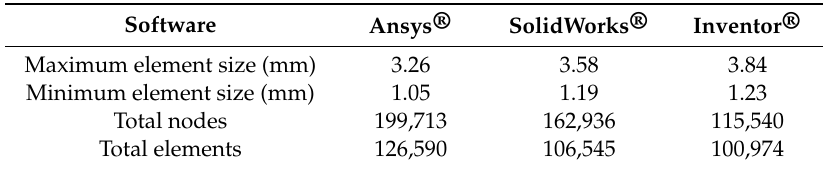
Table 2. Results of the size and number of elements of the mesh generated in the Ansys ® , SolidWorks ® and Inventor ® simulation software.